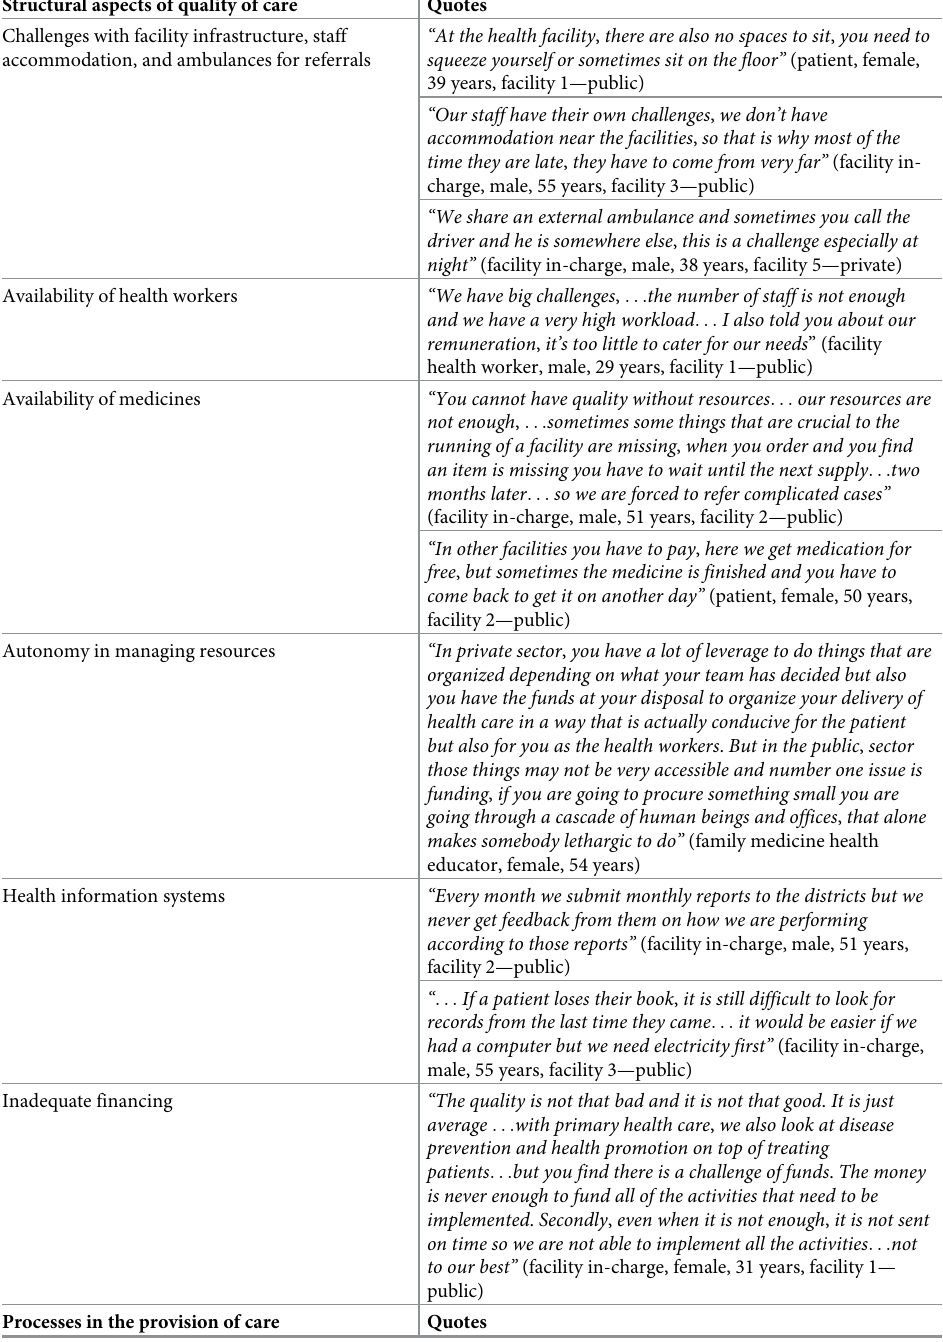
Table 4. Quotes exemplifying structural and procedural aspects affecting the quality of primary